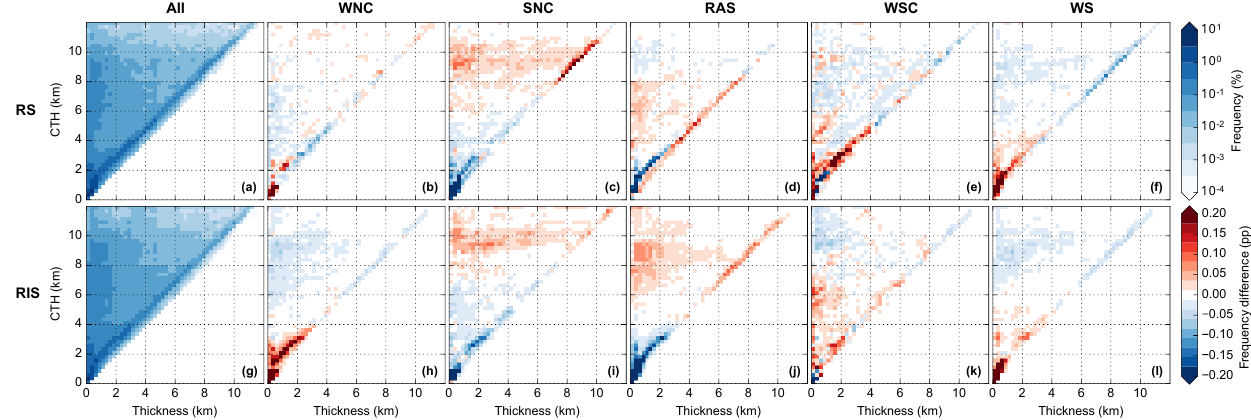
Figure 9. Joint histogram of the cloud top height vs. geometric cloud thickness over the Ross Sea and RIS for the entire year on a logarithmic scale (a, f) and the difference from the annual mean over the respective region (RS and RIS) for each Coggins regime on a linear scale (b–e, g–j)